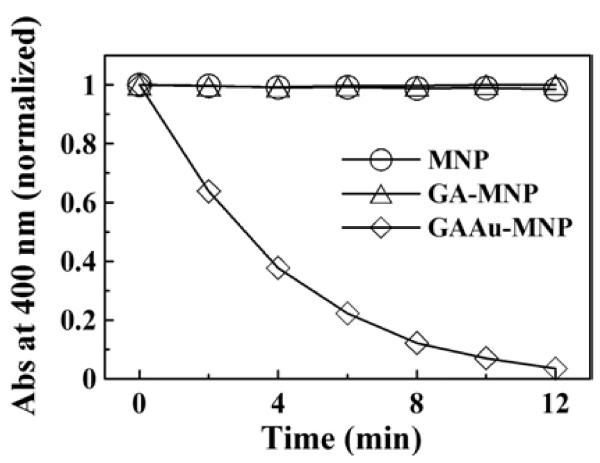
Absorbance variation with time at 400 nm for NaBH4-reduction of 4-NP with different nanoparticles. [Au]0 = 0.295 × 10−2 mg/mL, [4-NP] = 1.5 × 10−4 M, [NaBH4] = 1.5 × 10−2 M, 30°C.